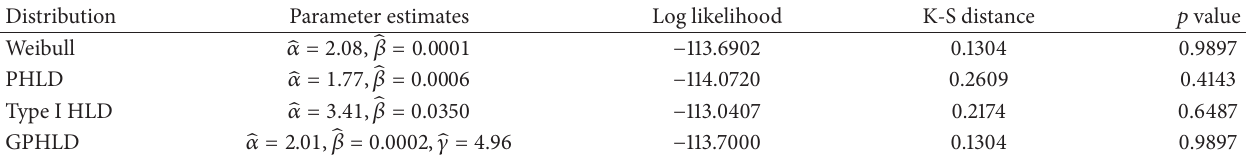
Table 5: Fitting based on data set 1.